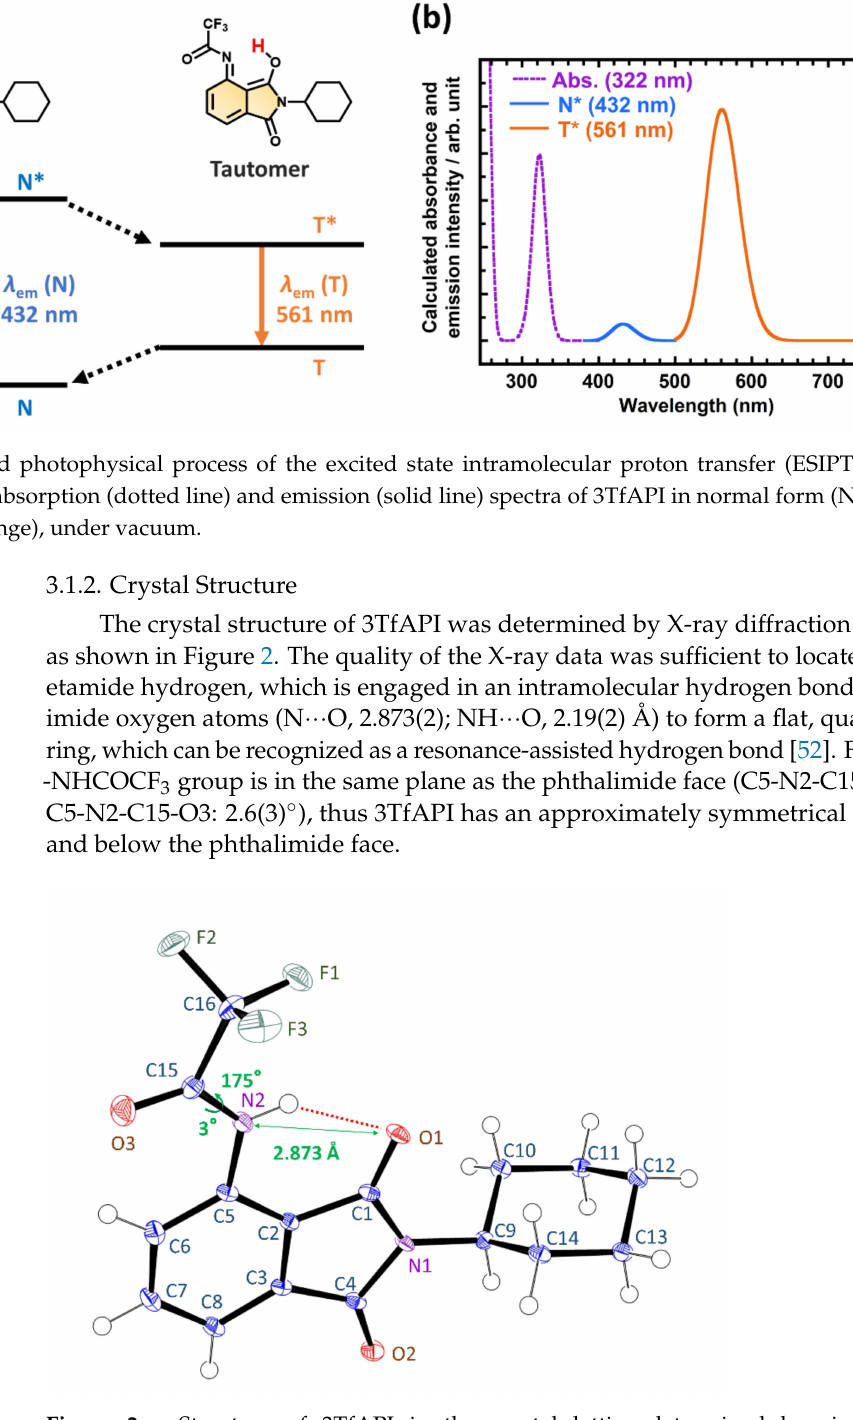
Figure 2. Structure of 3TfAPI in the crystal lattice determined by single-crystal X-ray diffraction